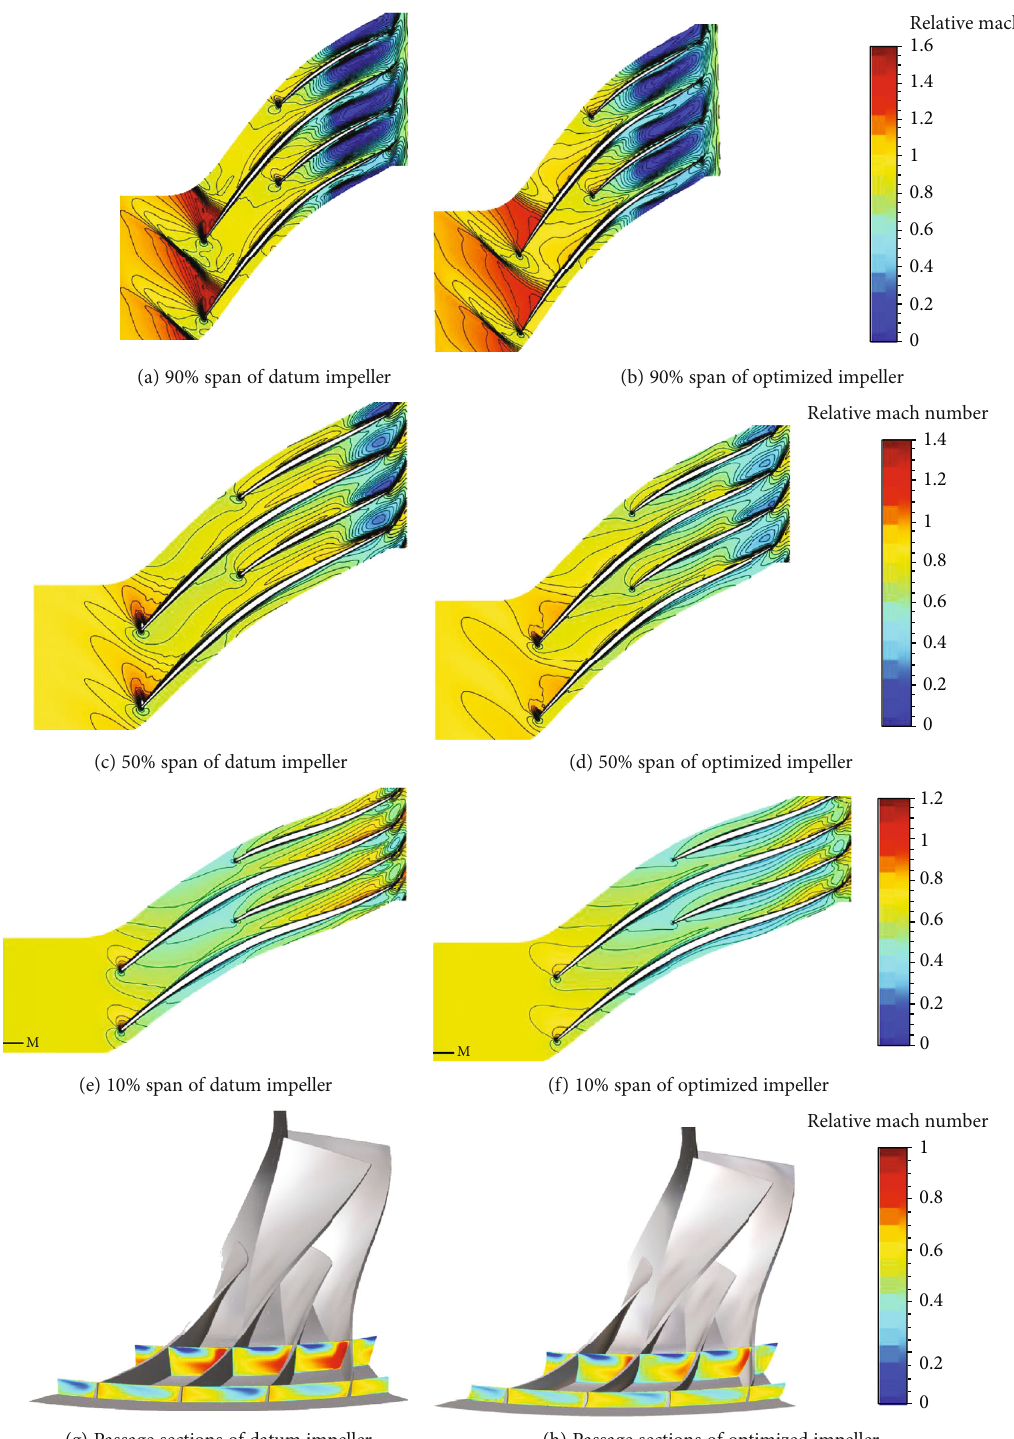
Figure 15: The fl ow- fi eld details of the datum and optimized